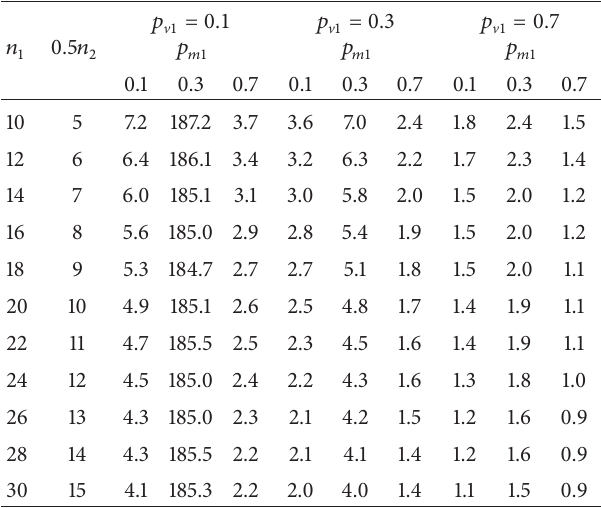
Table 10. The ARL 1 s for the combinations of 𝑛 1 = 10(2)30 ,